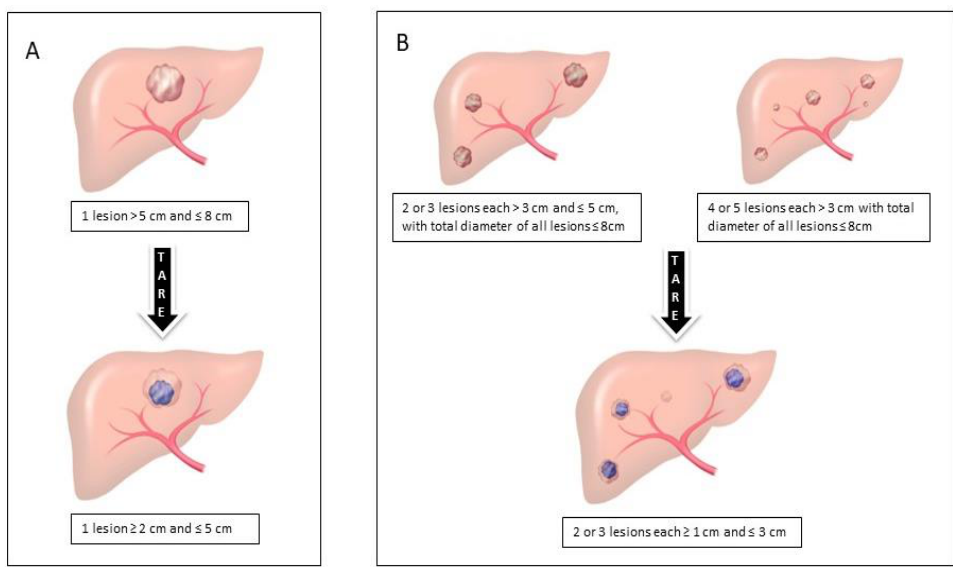
Figure 5. General aspects of the criteria for downstaging in patients with hepatocellular carcinoma who are candidates for liver transplantation. ( A ) Single lesion; ( B )Two or more lesions.